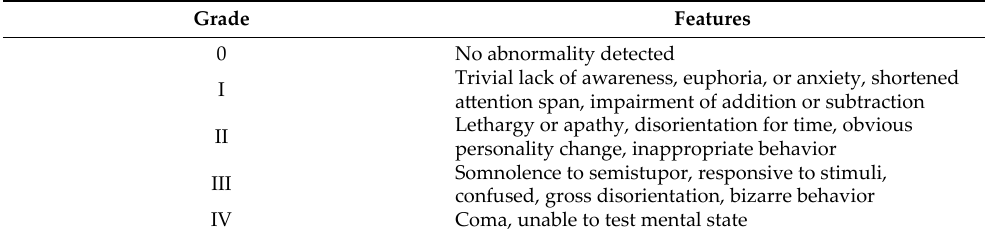
Table 1. West Haven